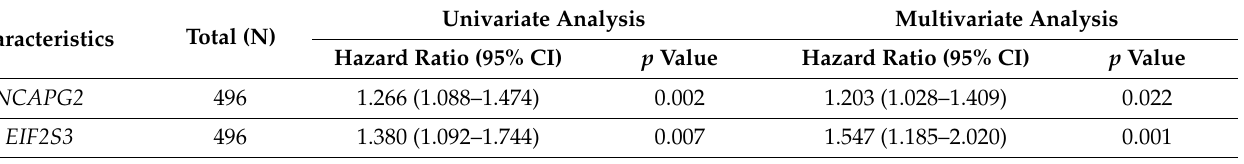
Table 1. Univariate and multivariate Cox